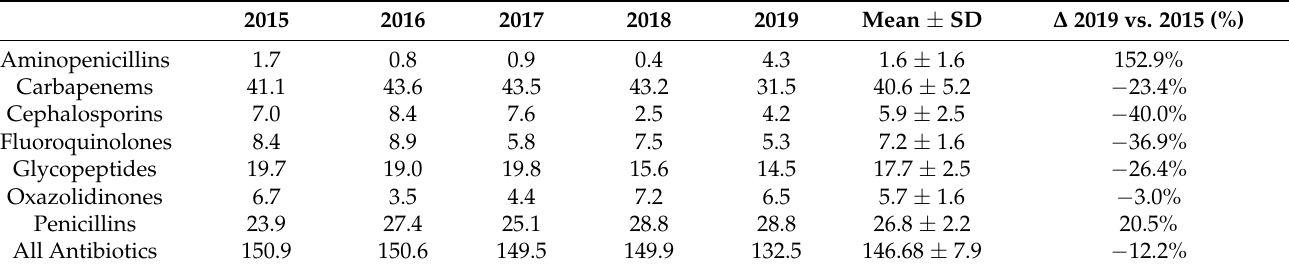
Table 1. Application density of antibiotics in RDD per 100